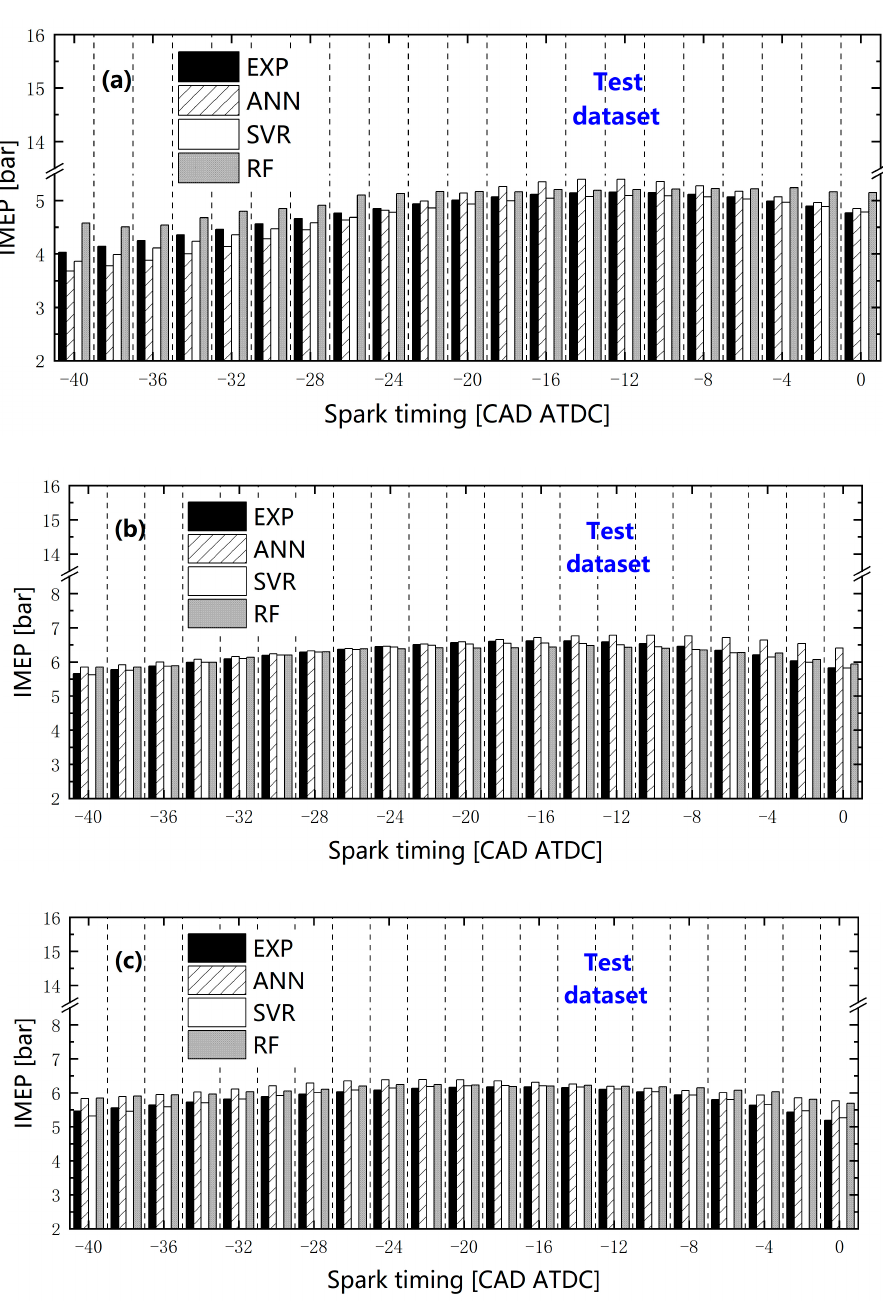
Figure 7. Comparison of predicted IMEP with actual values at low load: ( a ) low speed; ( b ) medium speed; ( c ) high speed .